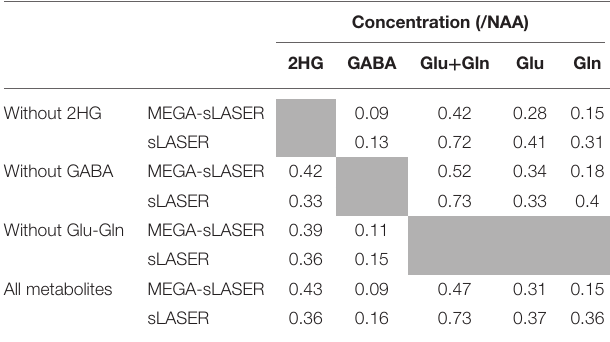
TABLE 2 | The relative concentrations (/NAA) obtained from MEGA-sLASER and TABLE 1 | CRLB (%) of overlapping metabolites. sLASER when excluding the overlapping metabolites from the basis CRLB (%) 2HG GABA Glu + Gln Glu Gln